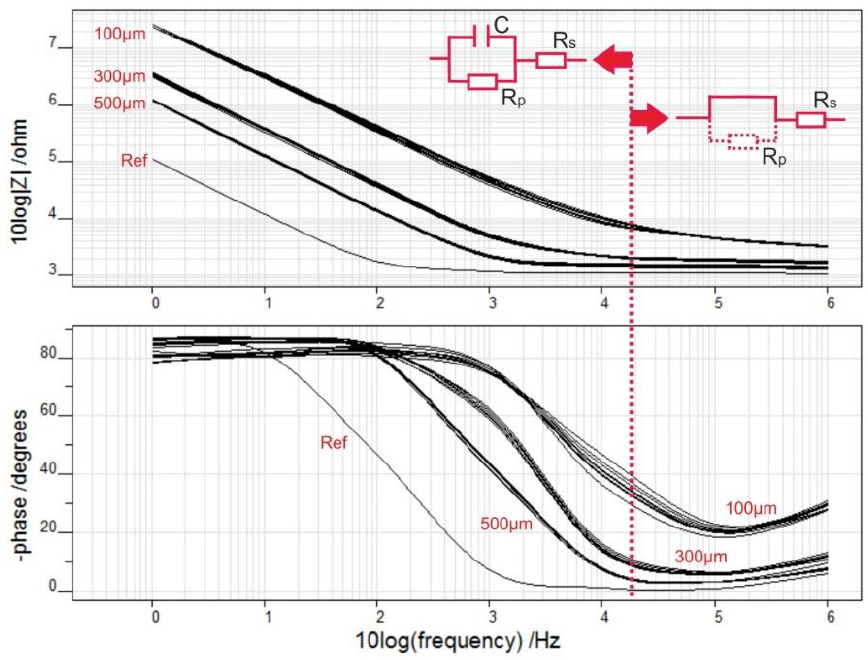
Figure 12. Impedance spectral bands according to electrode type; circuit